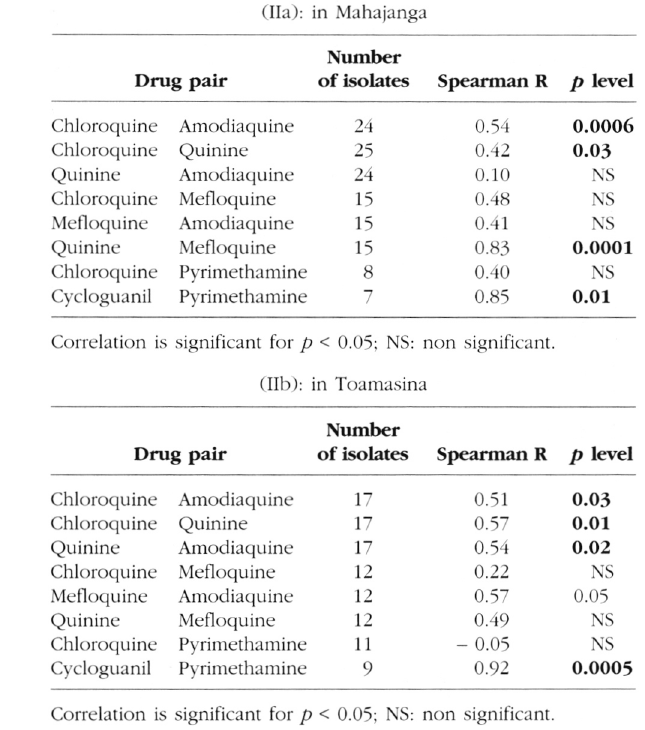
Table II. - Correlation of in vitro response of Plasmodium falciparum to major antimalarial drugs.